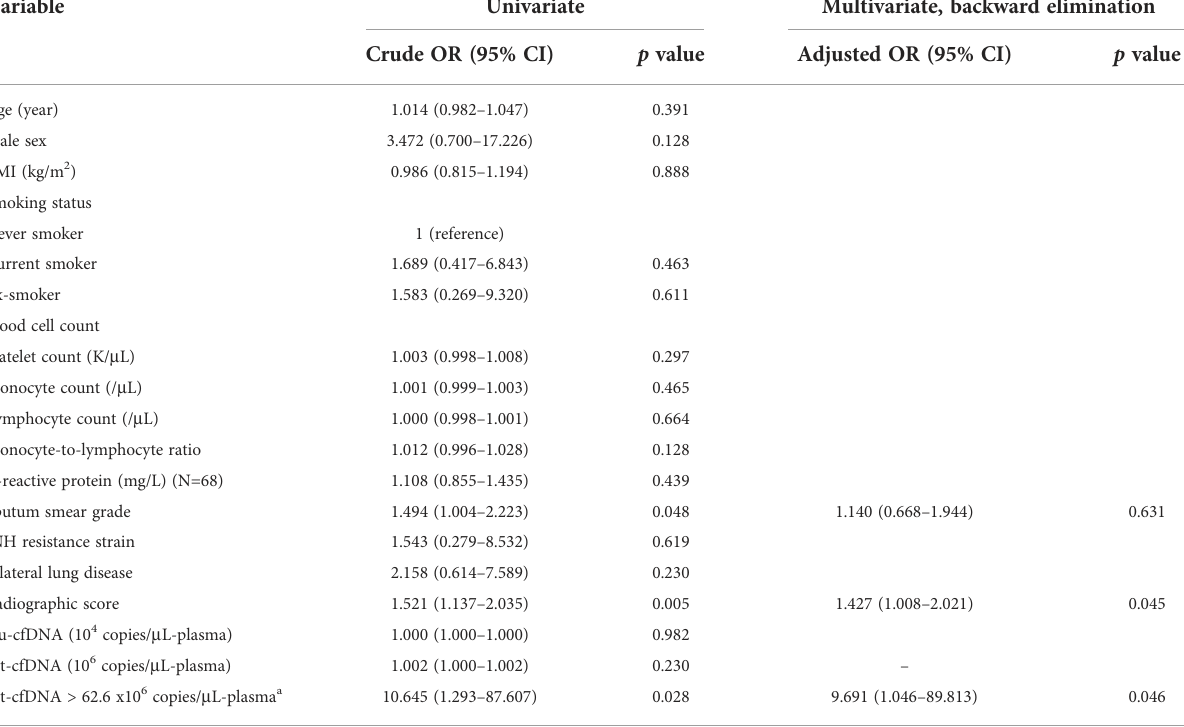
TABLE 3 Logistic regression model of factors associated with persistent culture-positive at 2 months of treatment in patients with PTB (N=73).